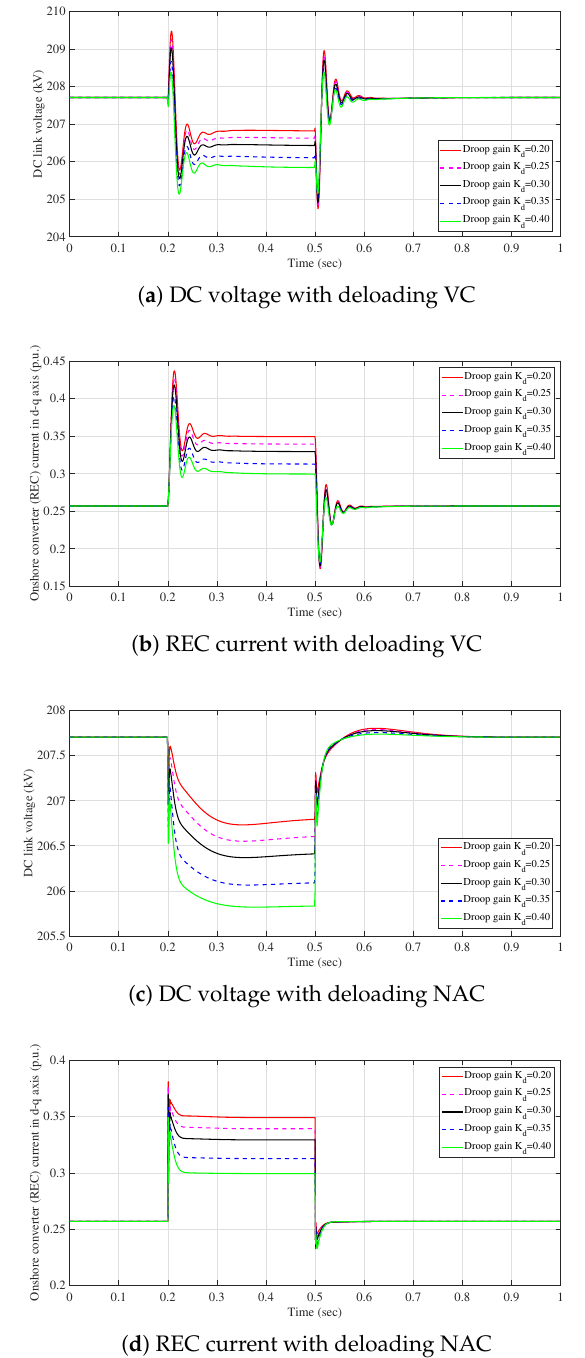
Figure 12. System responses obtained with 0.3 s duration of voltage sag with different de-loading droop